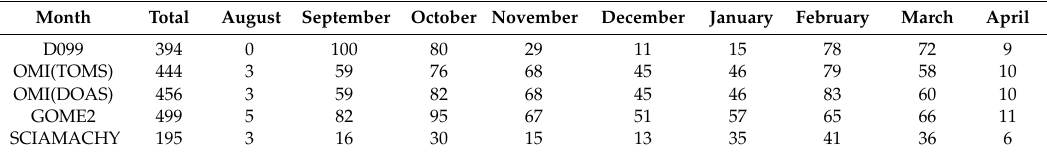
Table 1. Monthly numbers of TOC measurements coupled between the B199 and the studied data products at the Marambio Base for the period